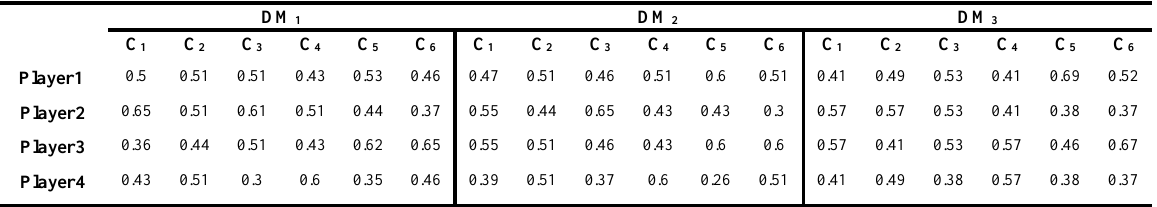
Table.5 . normalized decision matrixes of each DM